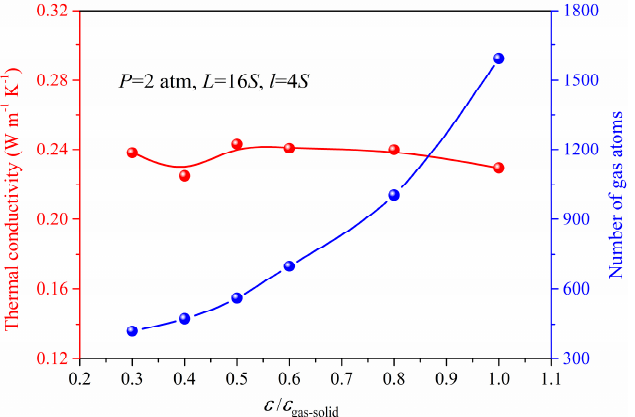
Figure 9. Gas atoms number and the thermal conductivity for different ε under the pressure of 2 atm.